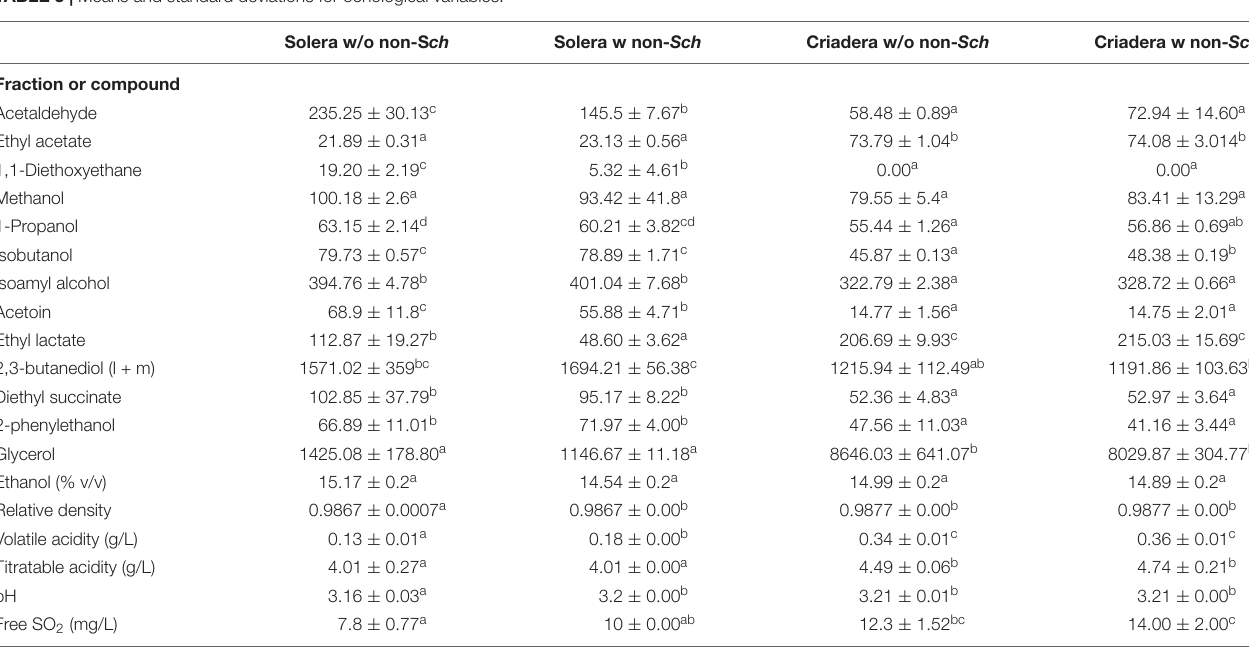
FIGURE 4 | Colony of a putative non- Saccharomyces yeast growing over flor yeast velum. (A) Sample of velum cultured in wine after 30 days at laboratory; (B,C) View of a non- Saccharomyces yeast growing on the flor with stereoscopic microscope at 10 × and 30 × ; (D) Morphology of the non- Saccharomyces yeast at 400 × . TABLE 3 | Means and standard deviations for oenological